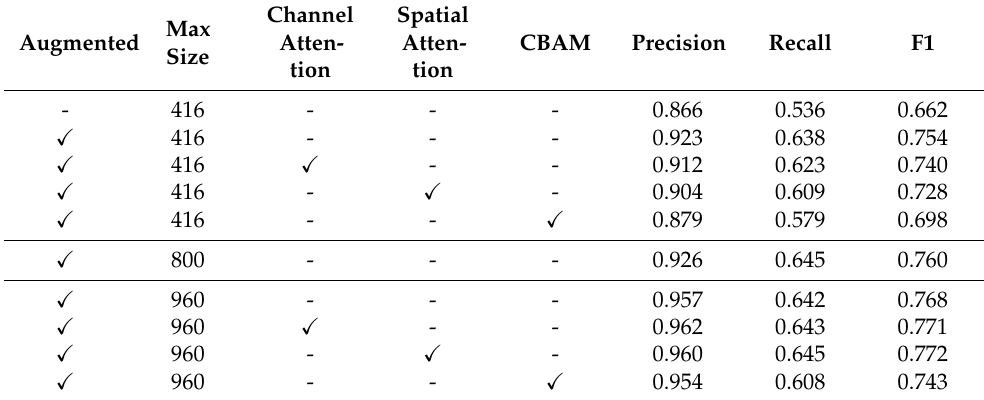
Table 3. Performance of the FCOS with different improvement techniques on the PSP